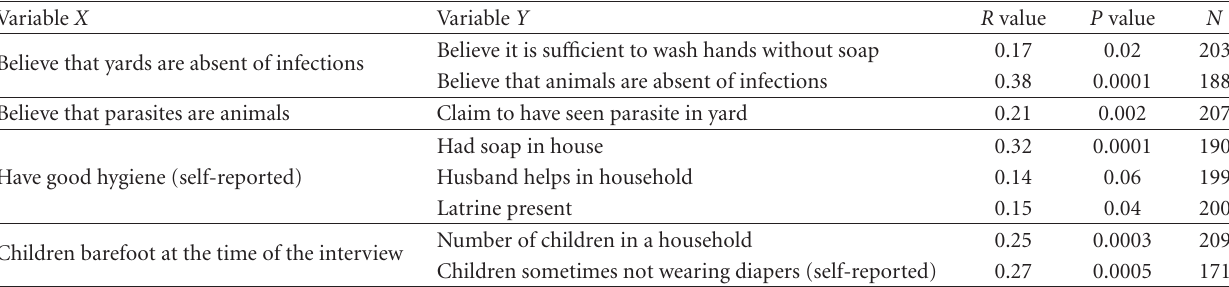
Table 5: Correlations among knowledge, attitude, and practice